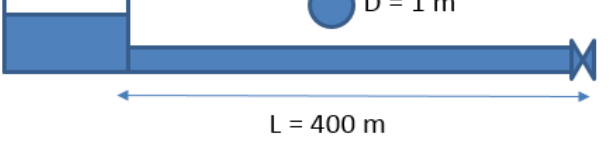
Figure 11. Test case 4 schematic.